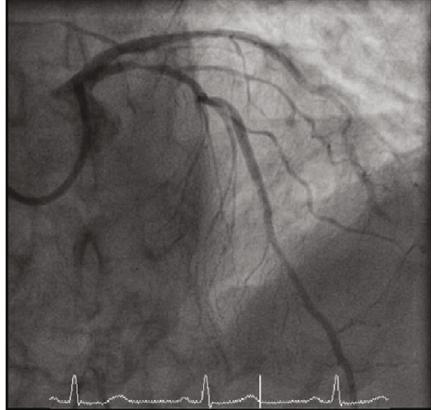
Figure 2: Coronary angiogram illustrating spasm in the LAD.